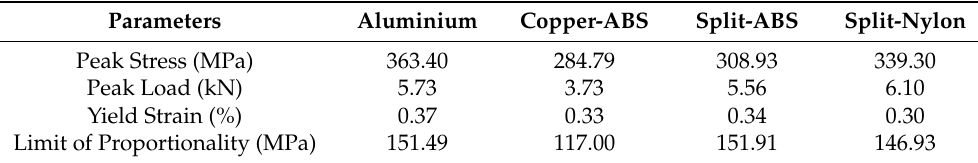
Table 2. Comparison of major mechanical properties for MIM parts.